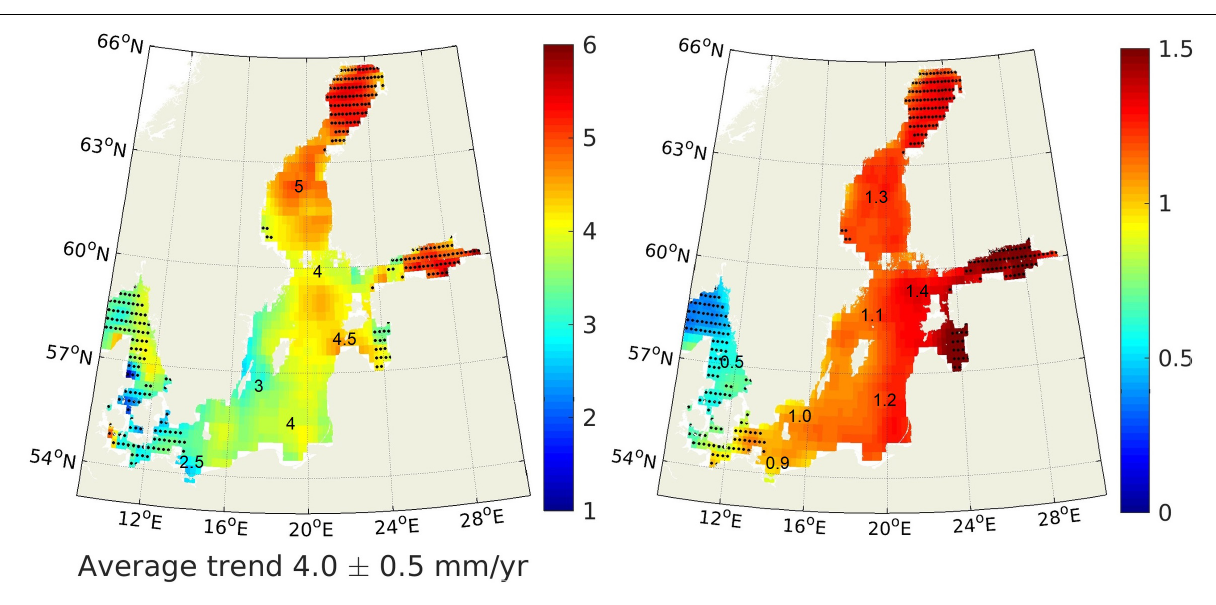
FIGURE 8 | Left: Spatial distribution of linear sea level trends in the Baltic Sea according to the CCI (1993–2015, mm/yr). Right: Corresponding trend error (mm/yr) fields as provided by the CCI. Black dotted areas denote the regions with decreased data quality of SLV_CCI according to this